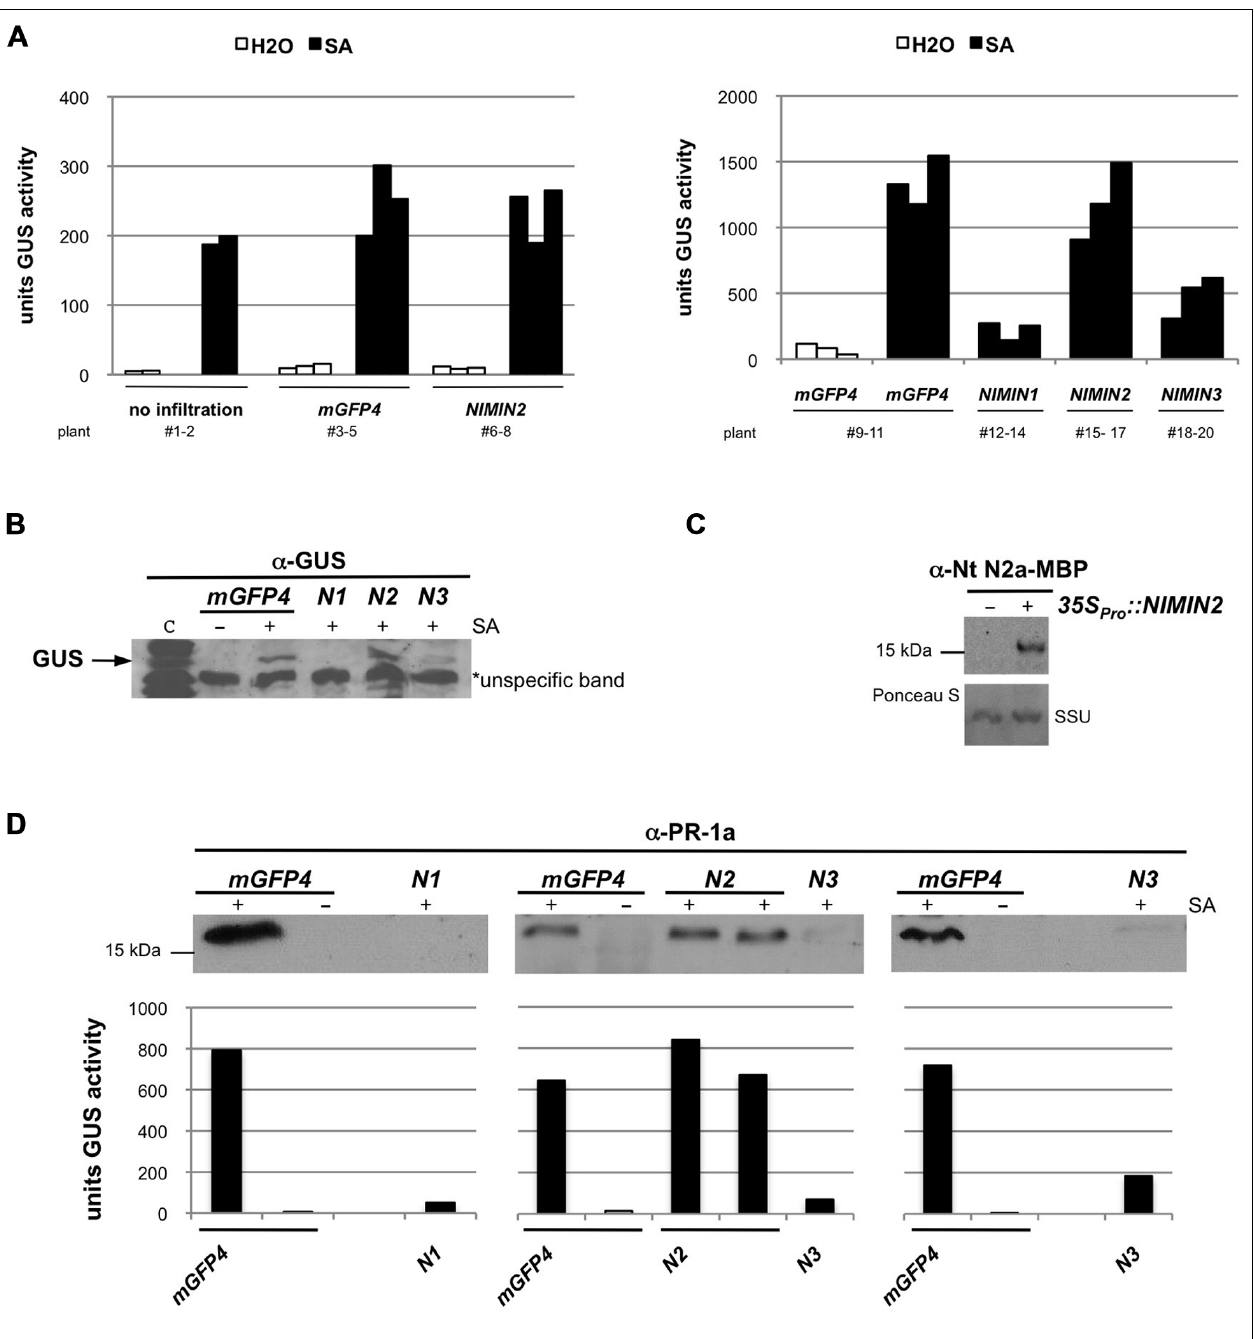
FIGURE 4 | Arabidopsis NIMIN2 does not affect salicylic acid-induced gene expression from the tobacco PR-1a promoter in N. benthamiana . Transient expression assays and immunodetection were performed as described in Figure 3 . N1, NIMIN1; N2, NIMIN2; N3, NIMIN3. (A) Effects of transient expression of 35S Pro ::NIMIN2 in the N. benthamiana - 1533PR-1a Pro ::GUS reporter line.The effects of NIMIN2 on the PR-1a::GUS reporter are compared to effects produced by NIMIN1 and NIMIN3. Representative results are shown. (B) Effects of transient expression of